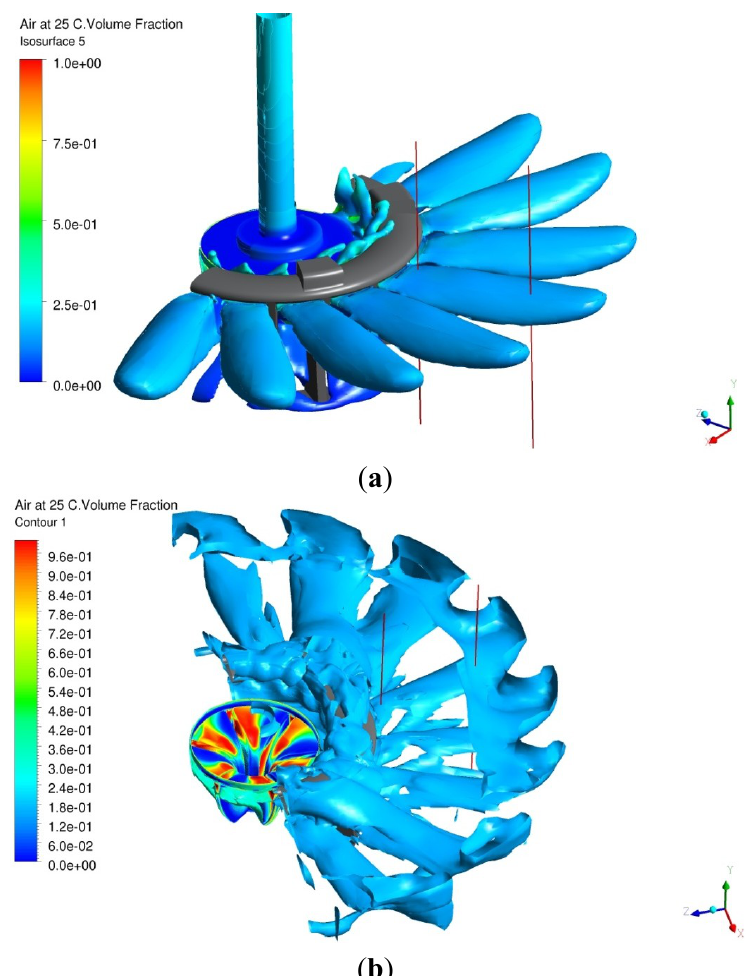
Figure 4. ( a ) Iso-surface of water superficial velocity ( V downstream of stator and ( b ) iso-surface of air volume fraction of (α = 0.15), lines at radii r = 0.52 and 0.92 m.